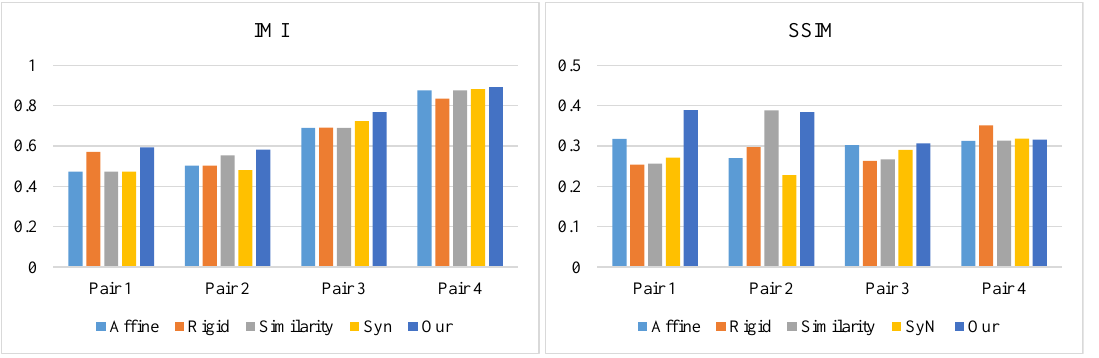
Figure 10. Visual comparison of different medical image registration methods on our datasets.